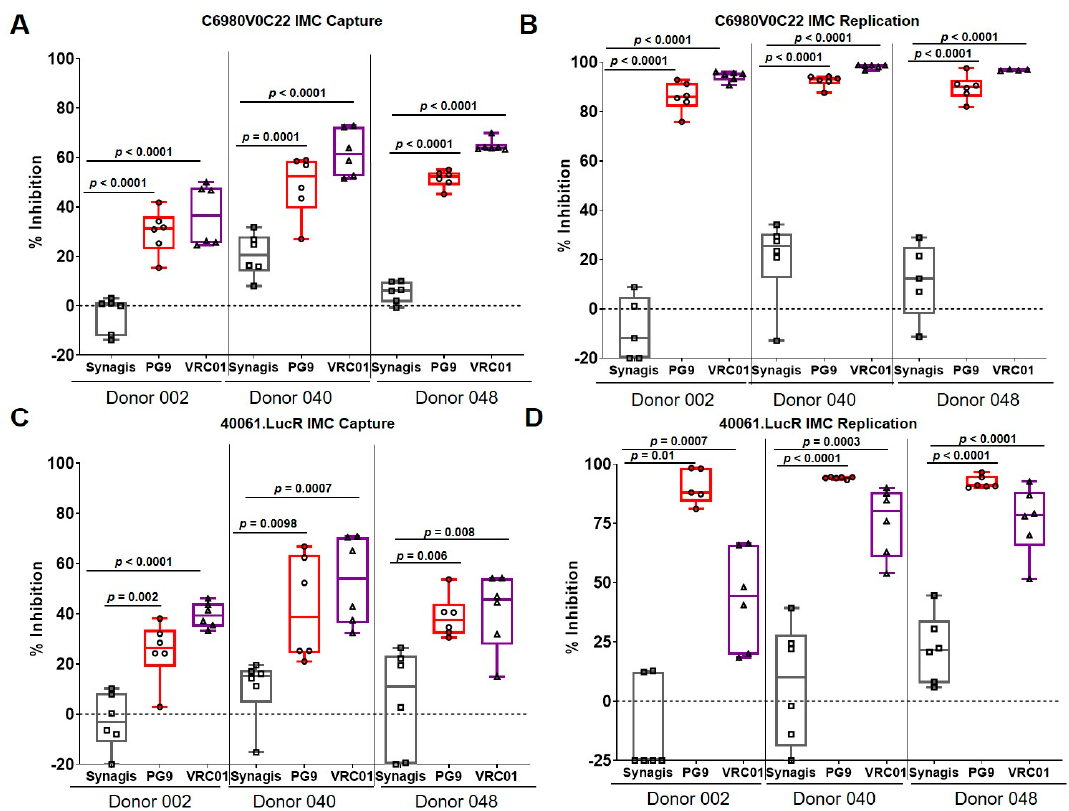
Figure 4. bNAbs inhibited virus capture and replication of C6980V0C22 and 40061.LucR IMCs. ( A ) PG9 and VRC01 significantly ( p < 0.001) inhibited virus capture of the subtype C IMC, C6980V0C22 in all three donor PBMCs. ( B ) The two bNAbs also significantly ( p < 0.001) inhibited virus replication of all three donors examined. ( C ) PG9 and VRC01 significantly ( p < 0.01) virus capture of the CRF01_AE IMC, 40061.LucR for all three donor PBMCs. ( D ) The bNAbs also significantly inhibited virus replication of the IMC in the bulk PBMCs examined. The data are shown as box-whisker plots (the box extends from the 25th to 75th percentiles; min to max showing all points). The data shown are from at least 2 independent experiments performed in triplicate.